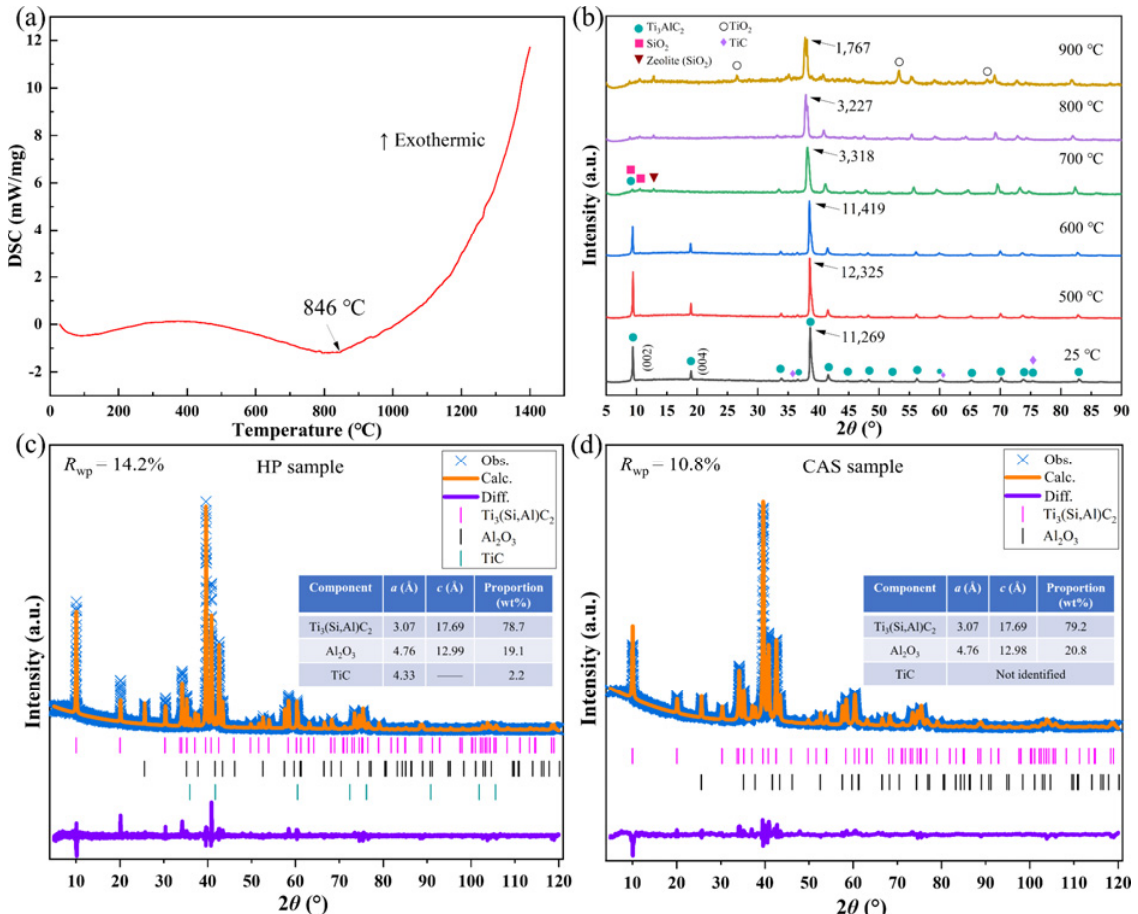
Fig. 1 (a) DSC results obtained by heating the raw materials (SiO and Ti 3 AlC 2 ) from room temperature to 1400 ℃ ; (b) high-temperature XRD patterns obtained by heating the raw materials (SiO and Ti 3 AlC 2 ) from room temperature to 900 ℃ ; (c) XRD Rietveld refinement results for the HP sample; and (d) XRD Rietveld refinement results for the CAS